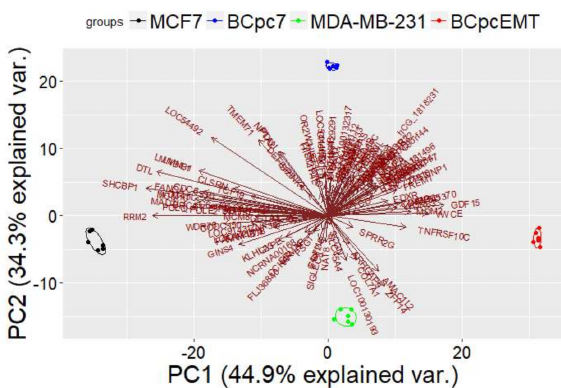
Figure 1. Principal component analysis considering gene signature shared in two breast cancer immortalized cell lines (MCF7 and MDA-MB-231) and in two BC primary cell cultures (BCpc7 and BCpcEMT).